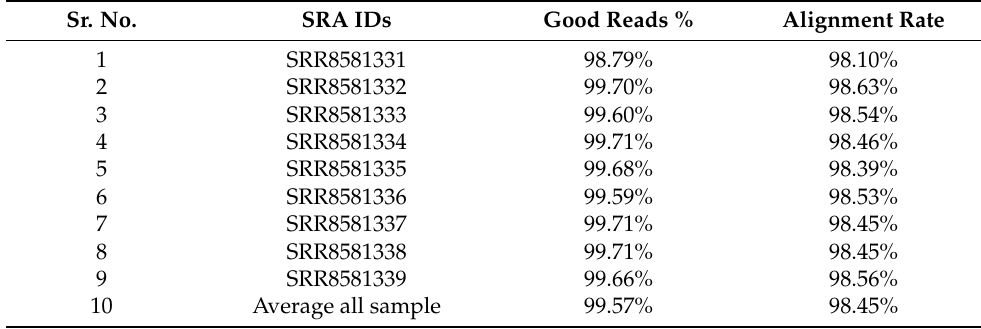
Table 1. Preprocessing and alignment results of all nine samples.